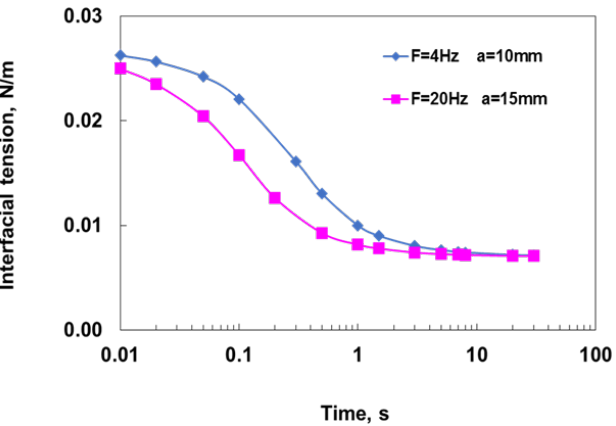
Figure 3. Calculated change in dynamic interfacial tension with oscillations determined from the solution of Equation (3).